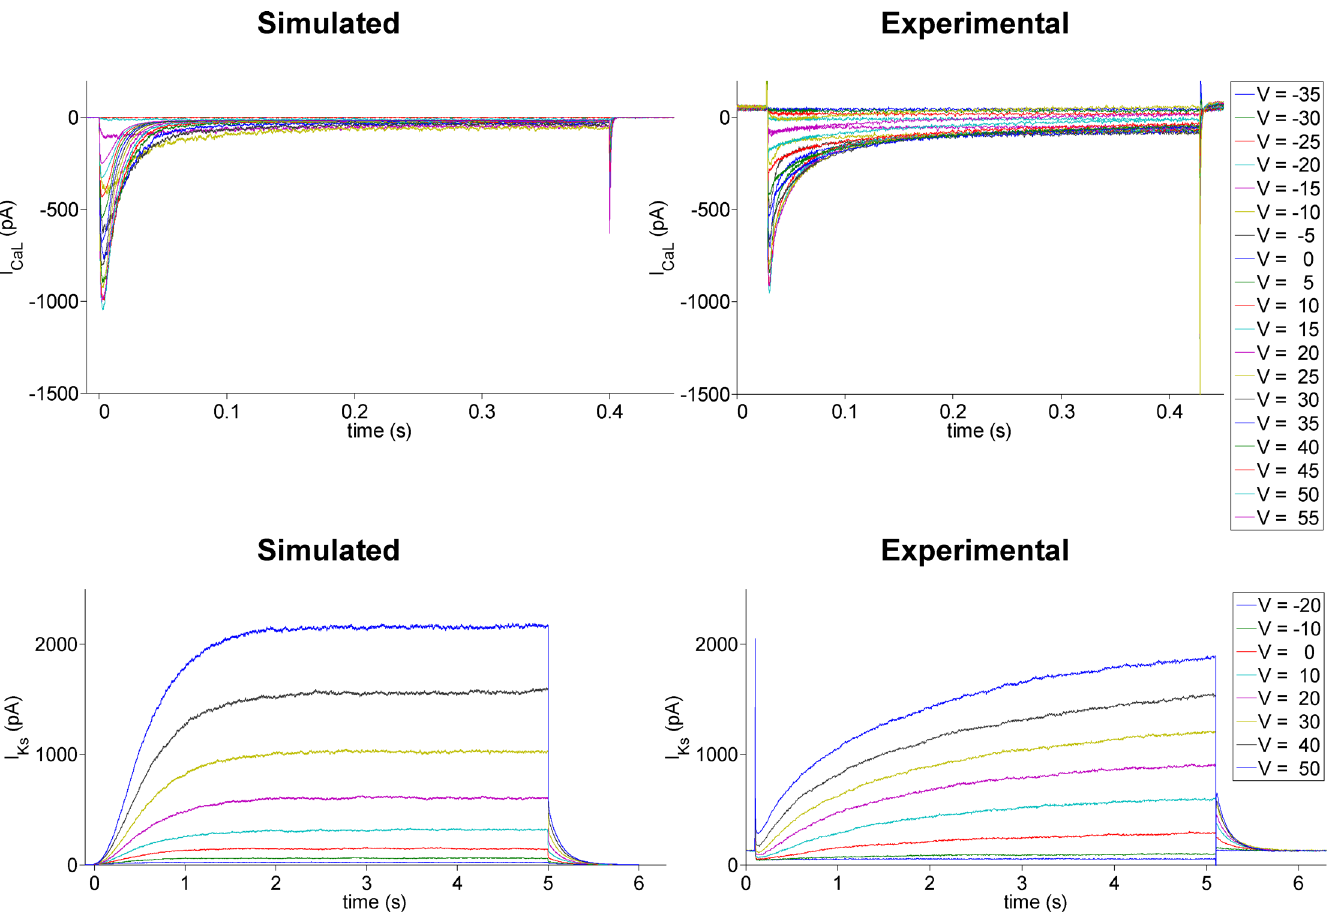
Fig 1. Simulated and experimental canine I CaL and I Ks traces. Examples of simulatedand experimental canine I CaL (top) and I Ks (bottom) traces, following voltage pulses from -40 mV to test potentials ranging from -35 to 55 mV in 5-mV increments in the case of I CaL and from -20 to 50 mV in 10-mV increments in the case of I Ks